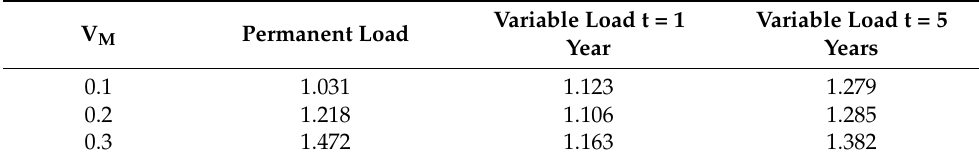
Table 2. Material safety factors for single loads.